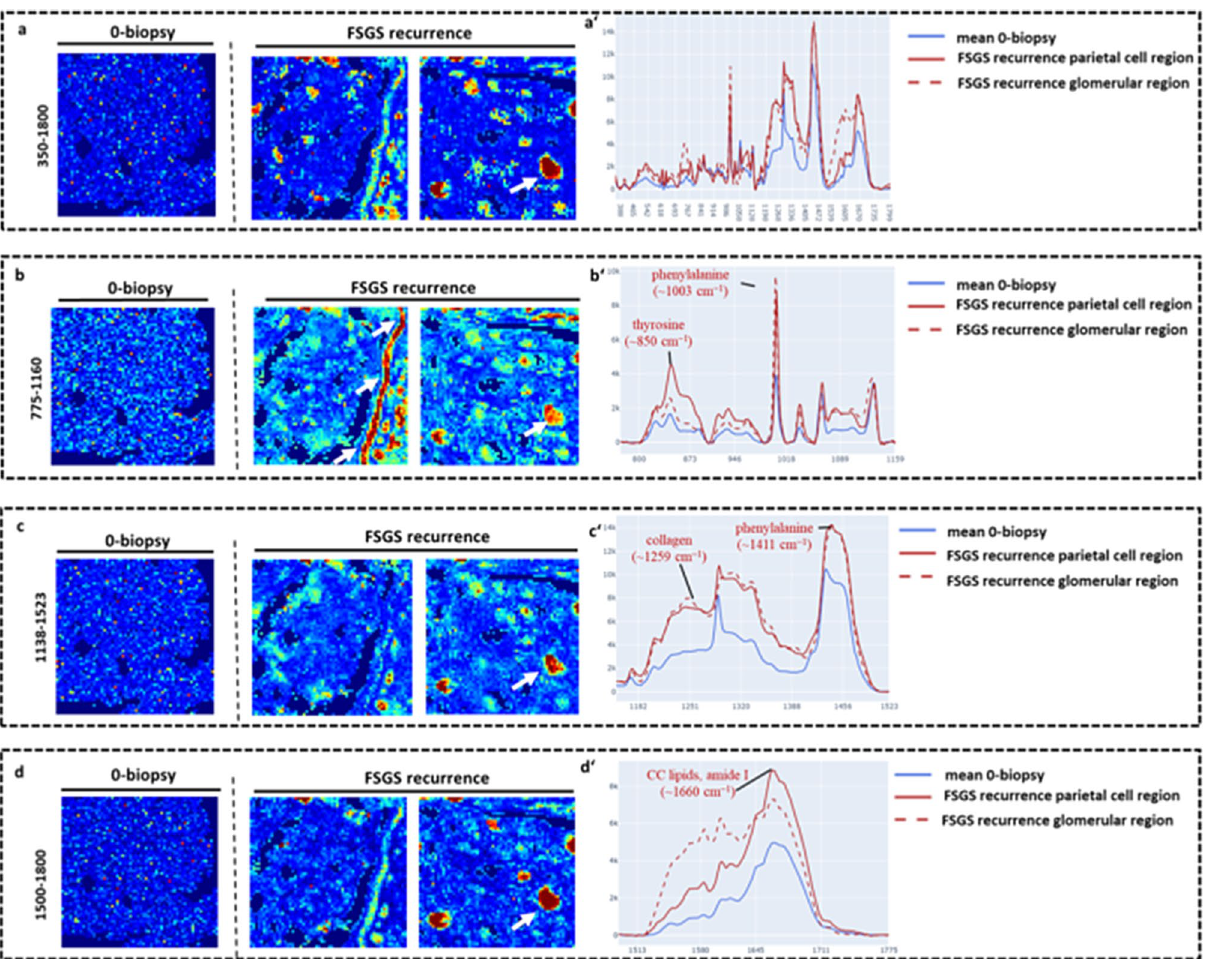
Figure 5. Machine learning reveals anomalies in Raman spectroscopy maps between 0-biopsy and FSGS recurrence. Raman spectra of glomeruli from the 0-biopsy and two glomeruli from the biopsy with FSGS recurrence were visualized, whereby the intensity and color range cover the degree of the anomaly. Areas of focal glomerular lesions as well as parietal epithelial cells in the Bowman capsule are highlighted as an anomaly in the FSGS samples. ( a ) Visualization of the occurring anomaly using the entire spectrum. ( b – d ) Consideration of only parts of the spectrogram that have been baseline corrected individually. Especially in the range of 775–1160 cm −1 ( b ) there were significant differences in FSGS glomeruli comparison to spectra from glomeruli of the 0-biopsy in focal areas as well in parietal cell region of the bowman capsule. Likewise, a similar effect was observed for the wavelength range 1138–1500 cm −1 ( c ) and 1500–1800 cm −1 ( d ). ( a ′ – d ′ ) Raman spectra for the anomalies with confidence > 80% in FSGS recurrence of the parietal cell region (red line) and the glomerular region (spotted red line) compared to 0-biopsy (blue line) for the entire spectrum ( a ′ ) and divided in